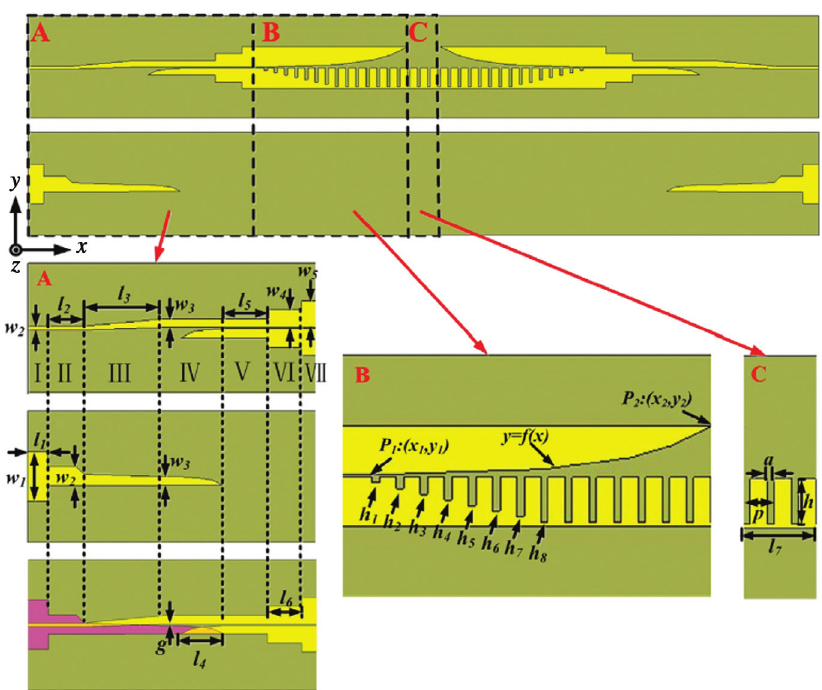
Figure 18: The sketch of back-to-back transition from microstrip to CSP waveguide. The transition divided into three regions (A, B, and C). The insets illustrate the detailed configurations of the three regions A, B, and C. Reproduced from [45] with